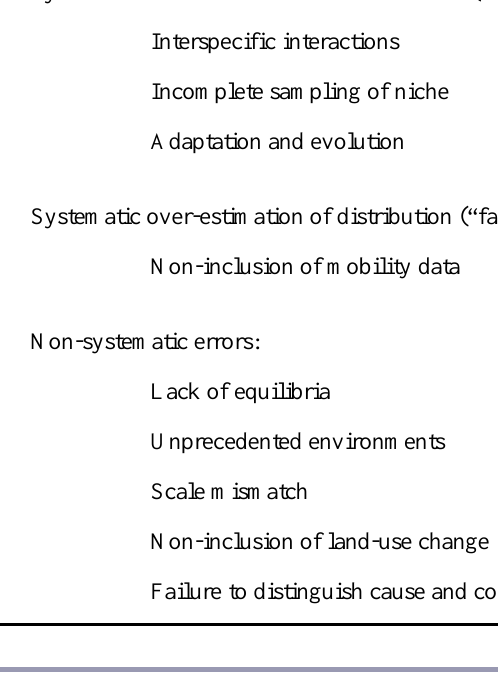
Table 1. Factors likely to cause over- or under-estimation of the extent of species’ distributions, with the application of SDMs to future climate scenarios. These conclusions assume that a basic SDM approach (i.e., correlation of distribution data with environmental data) has been applied, and no special efforts have been made to counter these factors. See text for an explanation of the reasoning. Systematic under-estimation of distribution (“false